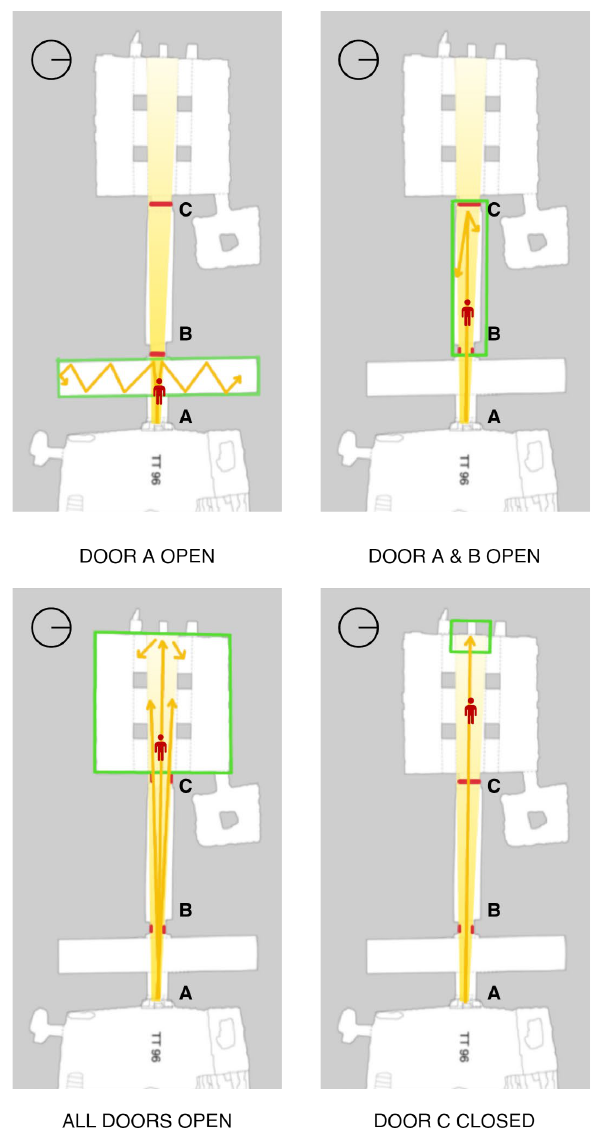
Figure 12. These schemes depict four main phases of the visitors’ experience and the involving impact of light along his route to the pillars’ hall.